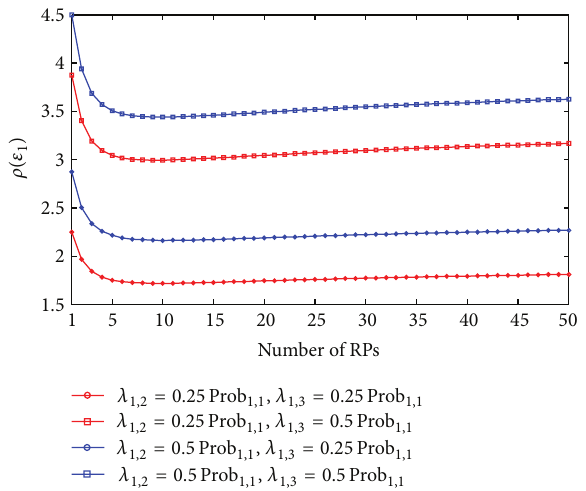
Figure 7: Variations of increasing rates of errors by one-neighbor matching ( 𝑟 = 1 m).